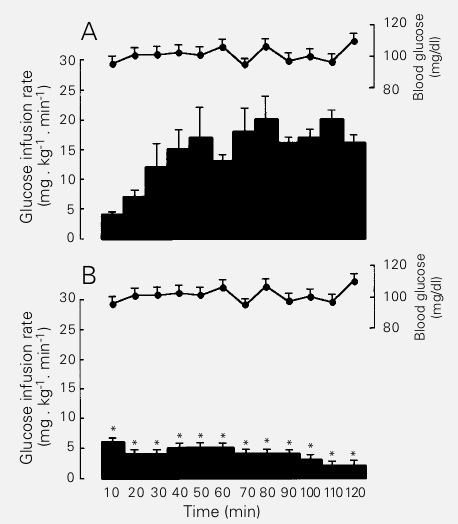
resistance in MSG-obese rats